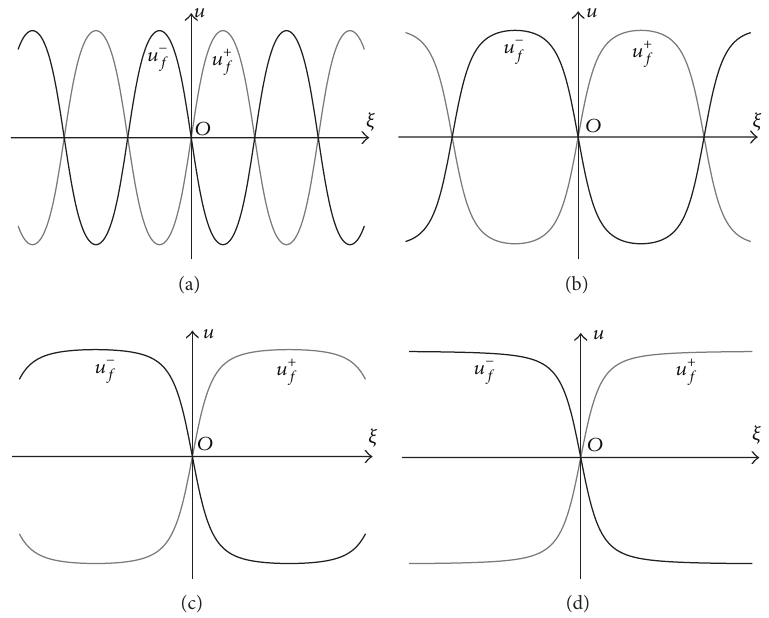
Figure 11: Two tall-kink waves are bifurcated form the symmetric periodic waves. The varying process for the figures of 𝑢 ± 𝑔 when (𝑎, 𝑏) ∈ 𝐴 3 and 𝑏 → −(5𝑎 2 /36𝑐) + 0 , where 𝑐 = 𝑎 = 1 , 𝛿 = 𝛾 = −1 , and (a) 𝑏 = −(5𝑎 2 /36𝑐) + 10 −2 , (b) 𝑏 = −(5𝑎 2 /36𝑐) + 10 −3 , (c) 𝑏 = −(5𝑎 2 /36𝑐) + 10 −4 , and (d) 𝑏 = −(5𝑎 2 /36𝑐) + 10 −7 .